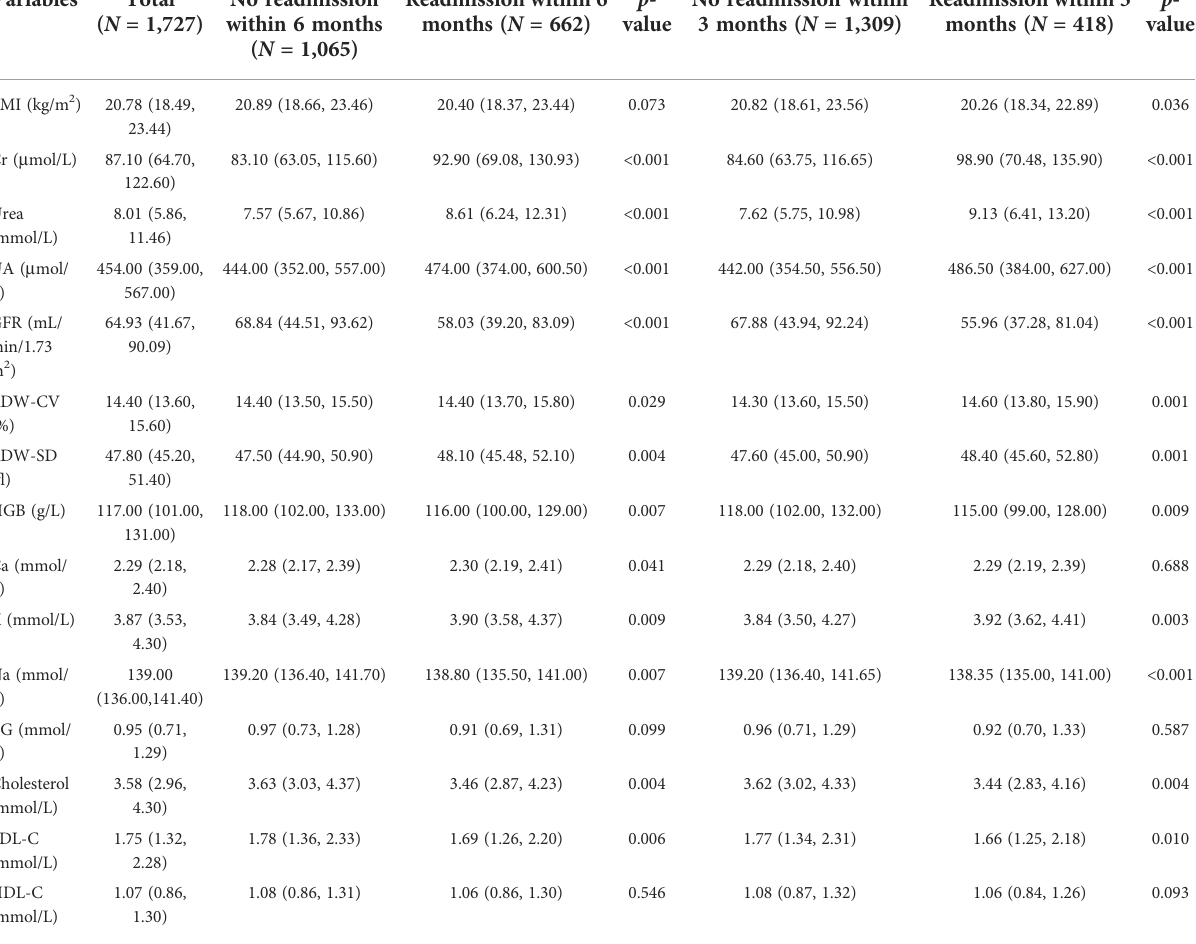
TABLE 2 Univariate analysis of continuous